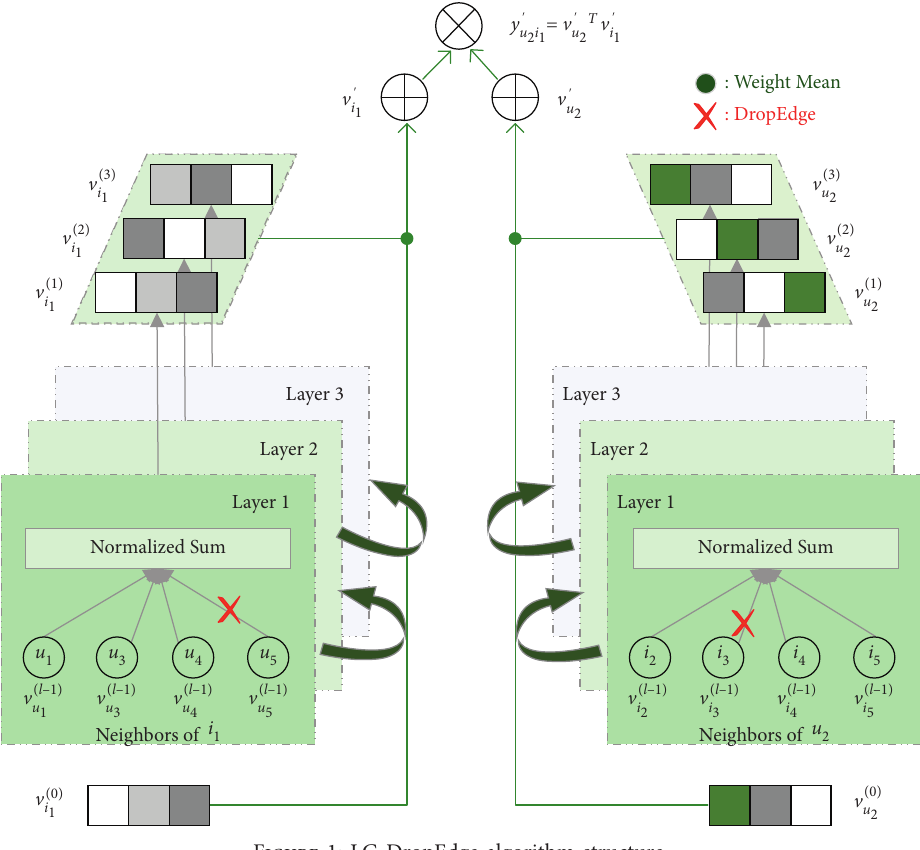
Figure 1: LG-DropEdge algorithm